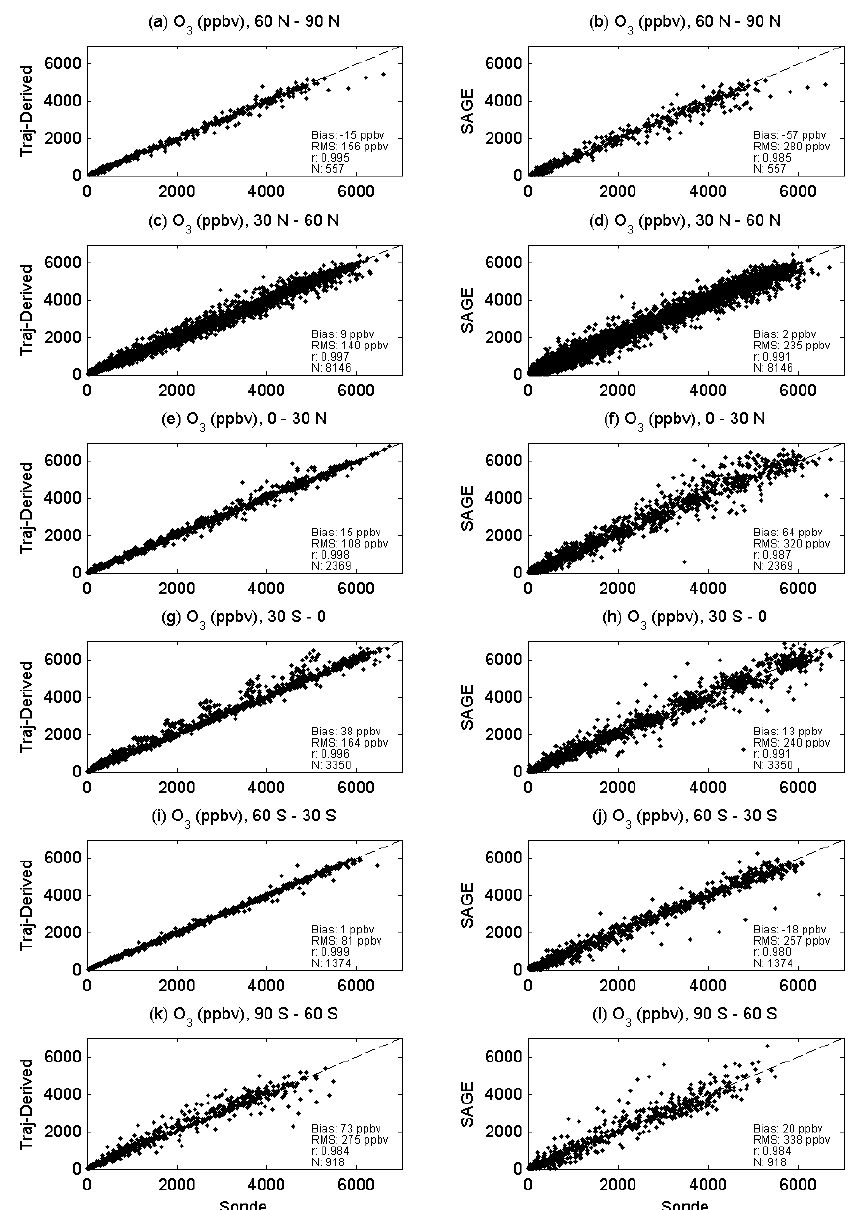
Fig. 6. Correlation ( r ) of ozone mixing ratio between trajectory-derived and ozonesonde data (left panels) and between SAGE and ozonesonde data (right panels) for the 1990s and 2000s for different latitude zones. The dashed line shows the 1 : 1 axis. N denotes the number of data points and RMS the root mean square error. All correlations are significant at a level better than 1%.